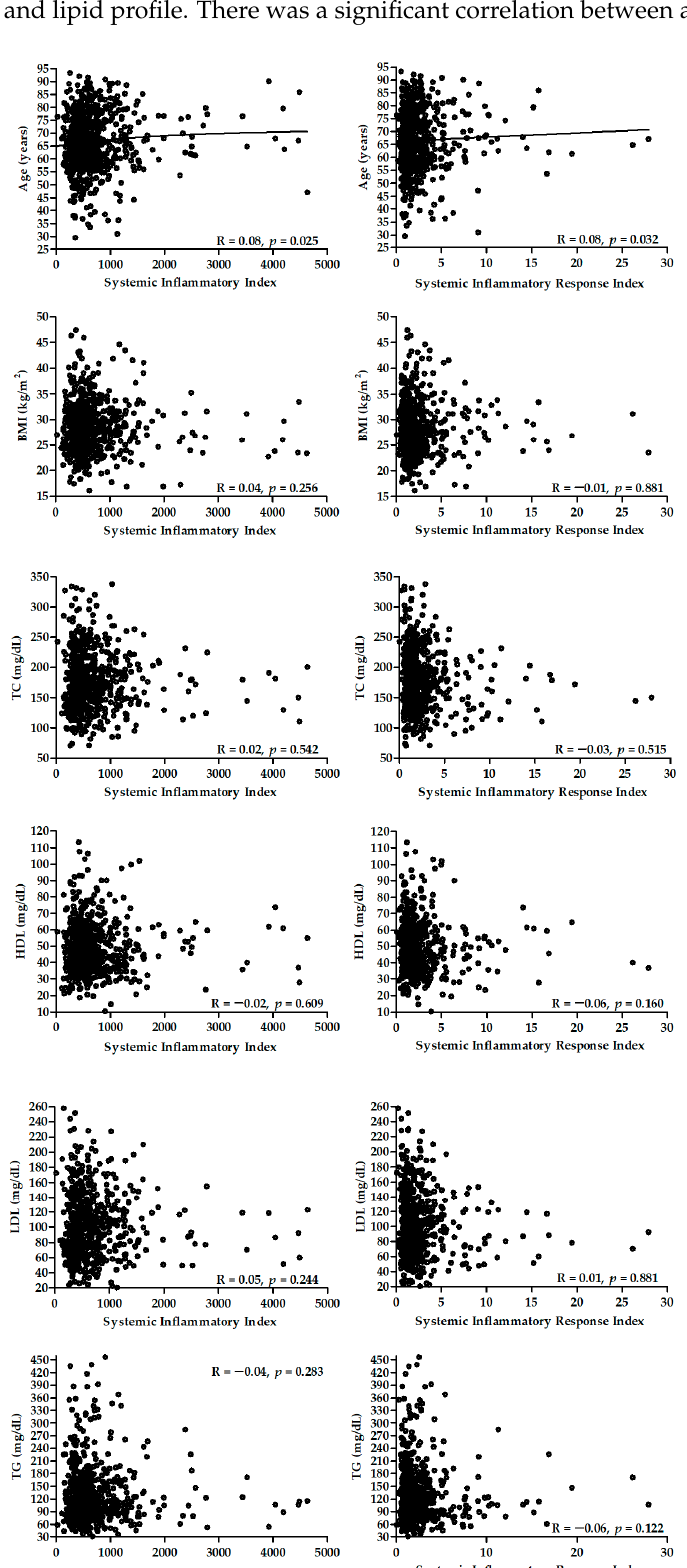
Figure 6. Correlation between SII ( left panel) and SIRI ( right panel) and age, BMI, and lipid profile.